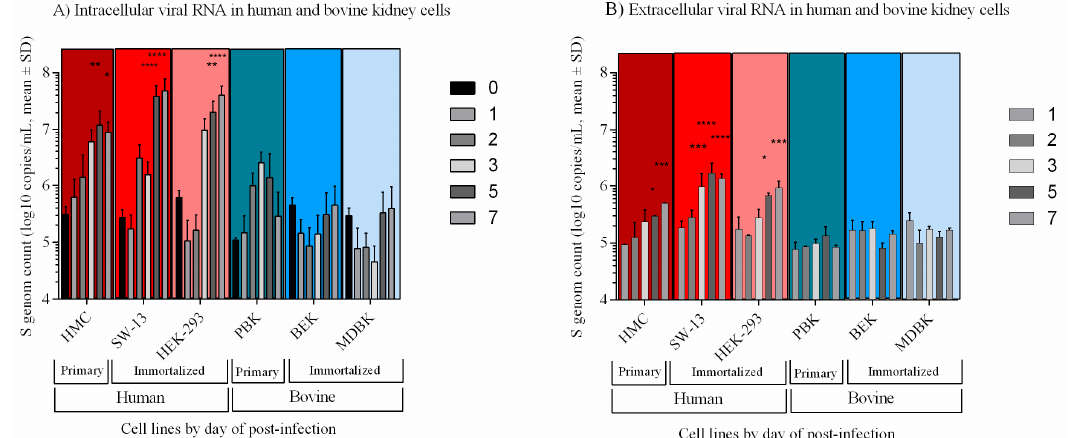
Figure 4. Di ff erential kidney cell line susceptibility to CCHFV, defined by intra- and extracellular gRNA copies at zero, one, two, three, five, and seven dpi. Measurements were taken in triplicate. The results represent both intra- and extracellular viral RNA. The mean viral loads on day one, two, three, five, and seven were compared to the mean viral load at day zero (1 h post-CCHFV inoculation). A significant increase in viral load was measured only in human cell lines. ( A ) Intracellular RNA in immortalized and primary cell lines; ( B ) extracellular RNA in immortalized and primary cell lines. All calculations based on log-transformed viral loads (copies / mL). * p -value ≤ 0.05, ** p -value ≤ 0.01, *** p -value ≤ 0.001, **** p -value ≤ 0.0001.